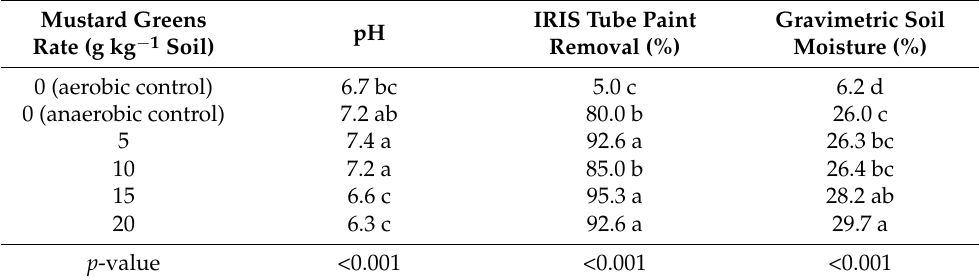
92.6 a 29.7 a p -value <0.001 <0.001